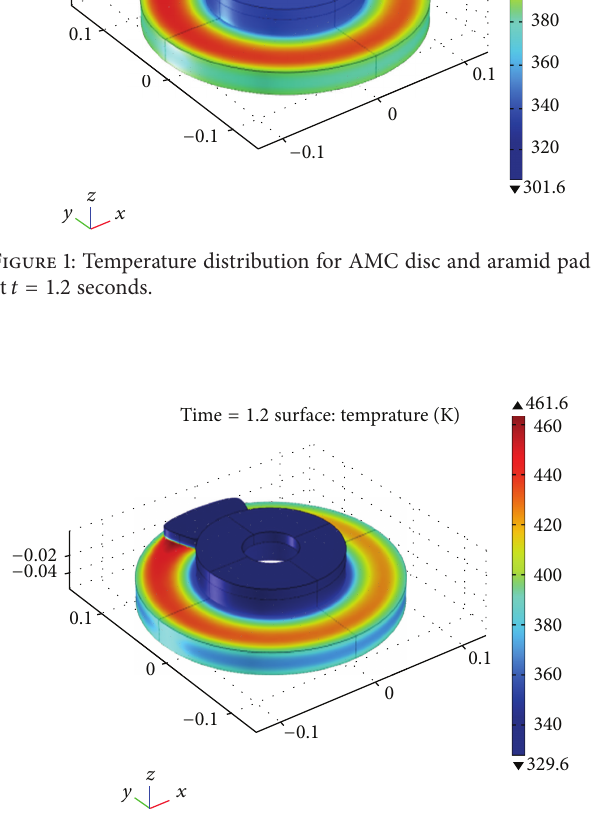
Figure 2: Temperature distribution for AMC disc and asbestos pad at 𝑡 = 1.2 seconds.